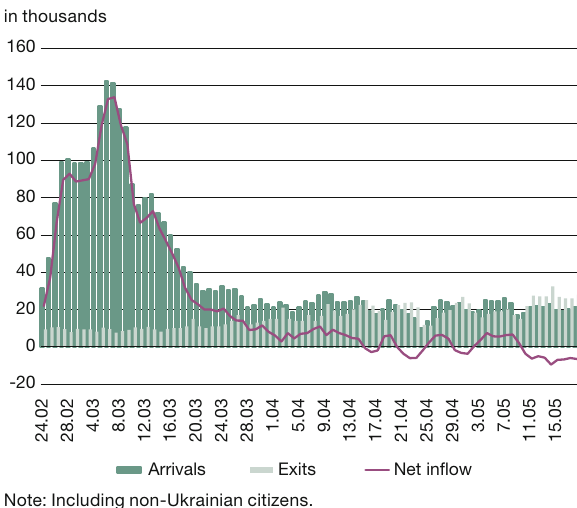
Daily border traffi c between Ukraine and Poland, Weekly changes in daily border traffi c between Ukraine and Poland, 24 February - 19 May